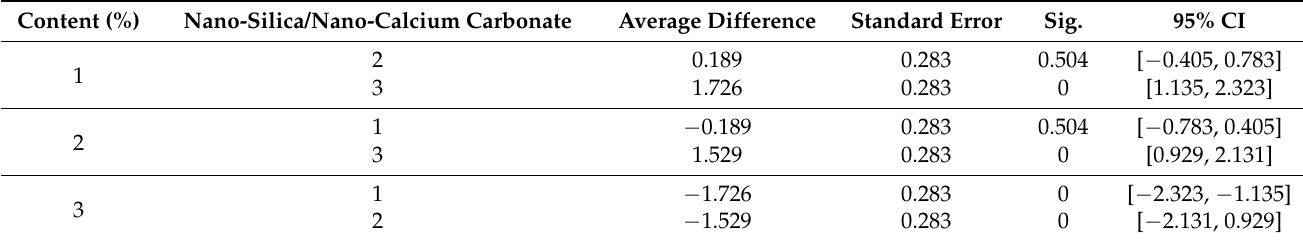
Table 2. Difference multiple